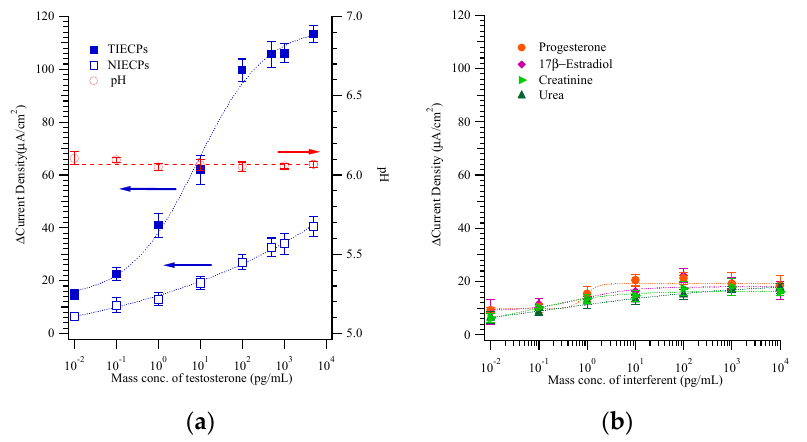
Figure 5. ( a ) The calibration curve of oxidation-peak current density and pH value from CVs against mass concentrations of testosterone on molecularly and non-imprinted poly(aniline- co -metanilic acid) based sensors. ( b ) The effect of the interferents (e.g., 17 β -estradiol (diamonds), progesterone (circles), urea (triangles), and creatinine (right triangles)) on peak current response was tested and is shown (n > 3). Table 1. Comparison of real sample measurement by ARCHITECT ci 8200 system and the TIECP sensors.